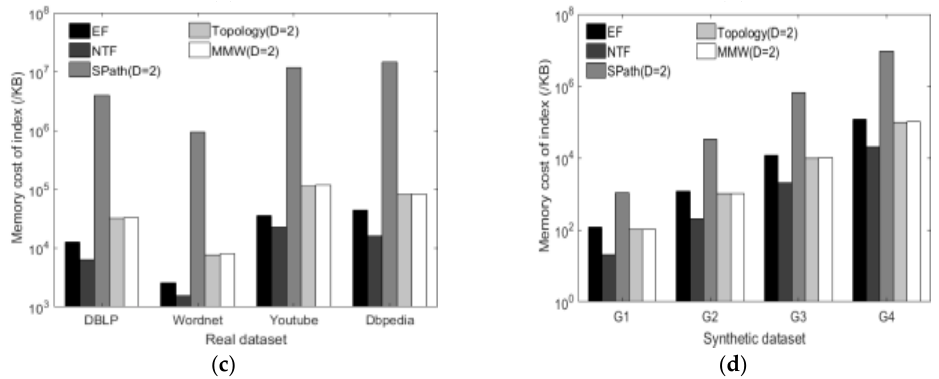
Figure 8. Comparison of construction time and memory cost for indexes. ( a ) Comparison of construction time in real datasets; ( b ) Comparison of construction time in synthetic datasets; ( c ) Comparison of memory cost in real datasets; ( d ) Comparison of memory cost in synthetic datasets.